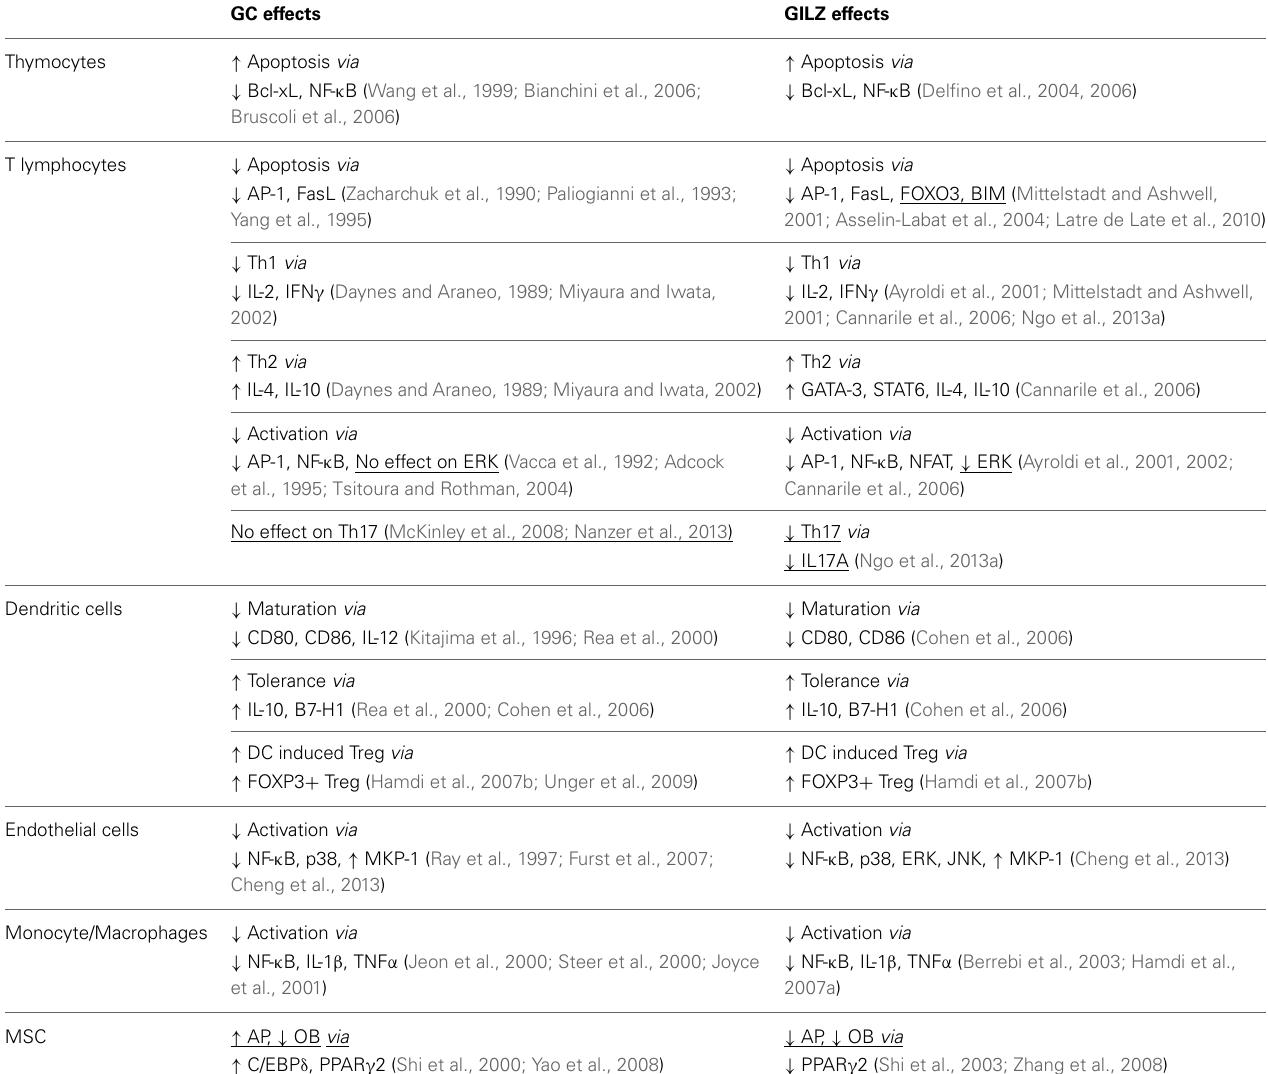
Table 1 | Comparison of GILZ and GC in vitro effects on specific cell